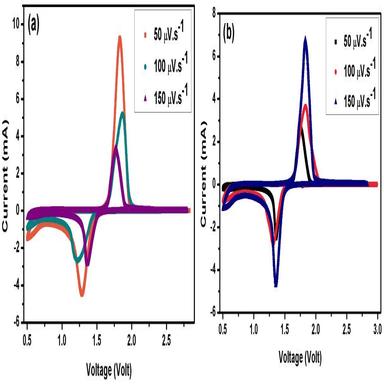
Cyclic voltammetry curves of (a) Pristine Li4Ti5O12; and (b) Li4Ti5O12 doped with Al.